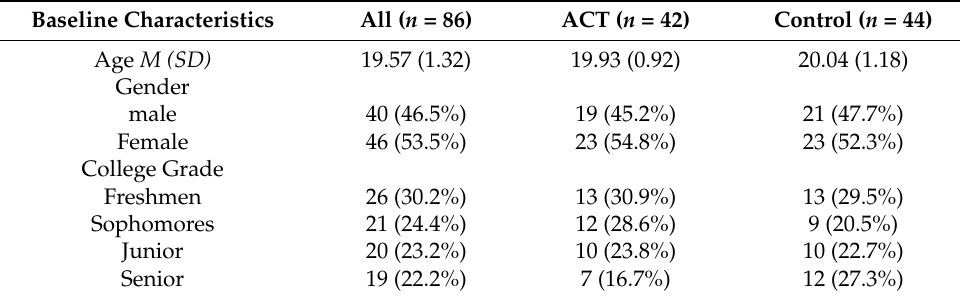
Table 1. Participant Demographics by